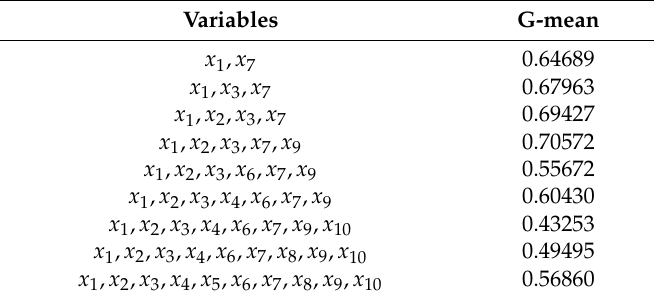
Table 3. G-mean value with a combination of variables.